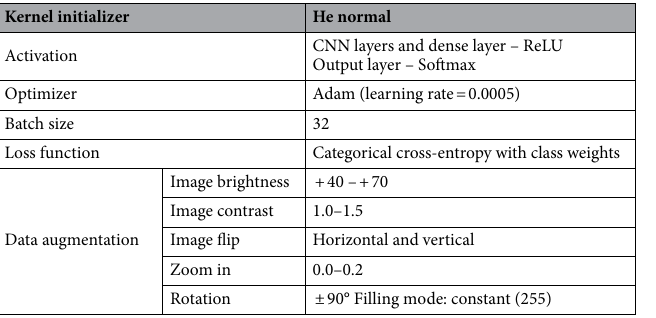
Table 3. Summary of the image classification model parameters.